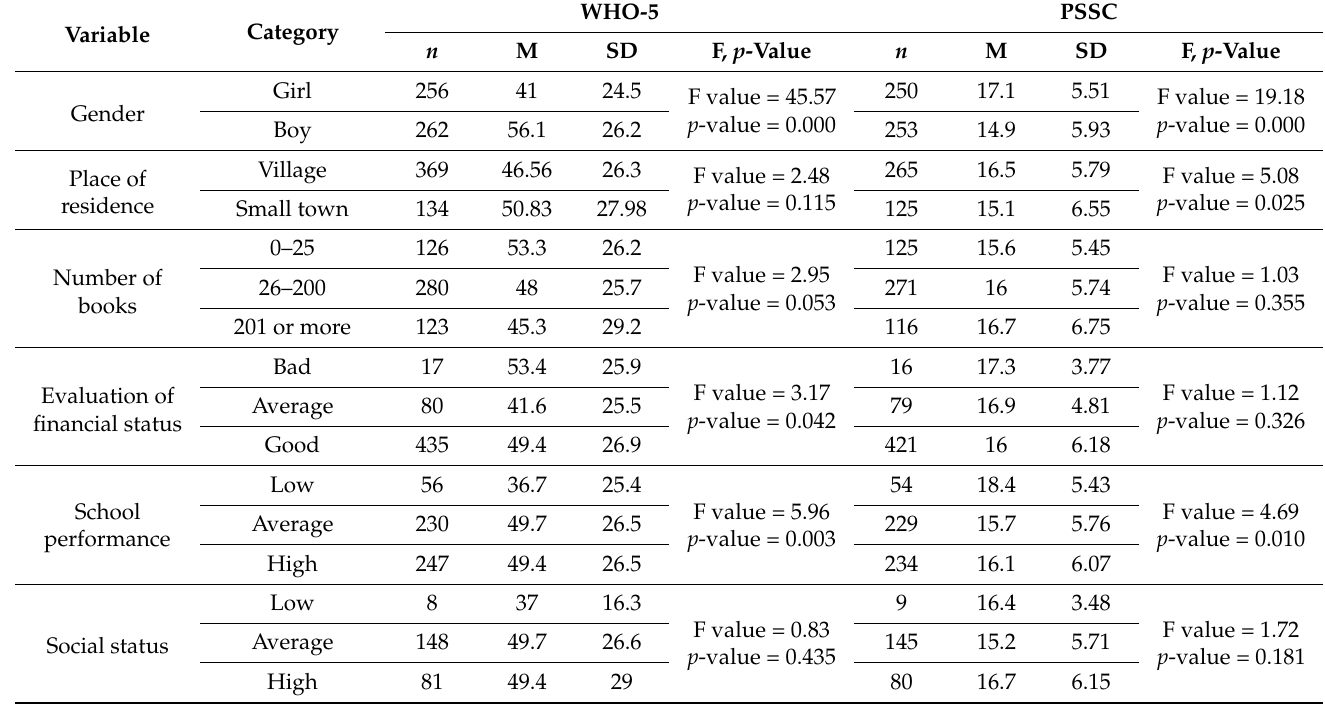
Table 5. Distribution of average values on the mental health scale in the categories of demographic and social